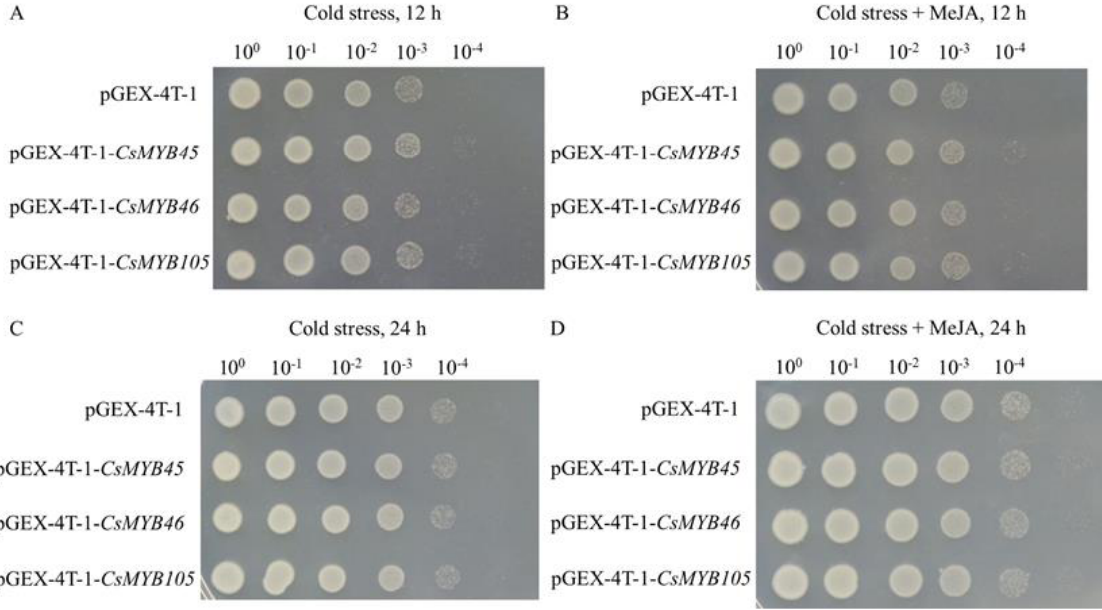
Figure 5. Spot assay of transgenic E. coli expressing pGEX − 4T − 1 − CsMYB45 , pGEX − 4T − 1 − CsMYB46 , pGEX − 4T − 1 − CsMYB105 , and pGEX − 4T − 1 (EV) on LB plates under cold stress at 16 °C for 12 h ( A ) and 24 h ( C ) and under the combined treatment with cold stress and exogenous MeJA for 12 h ( B ) and 24 h ( D ).